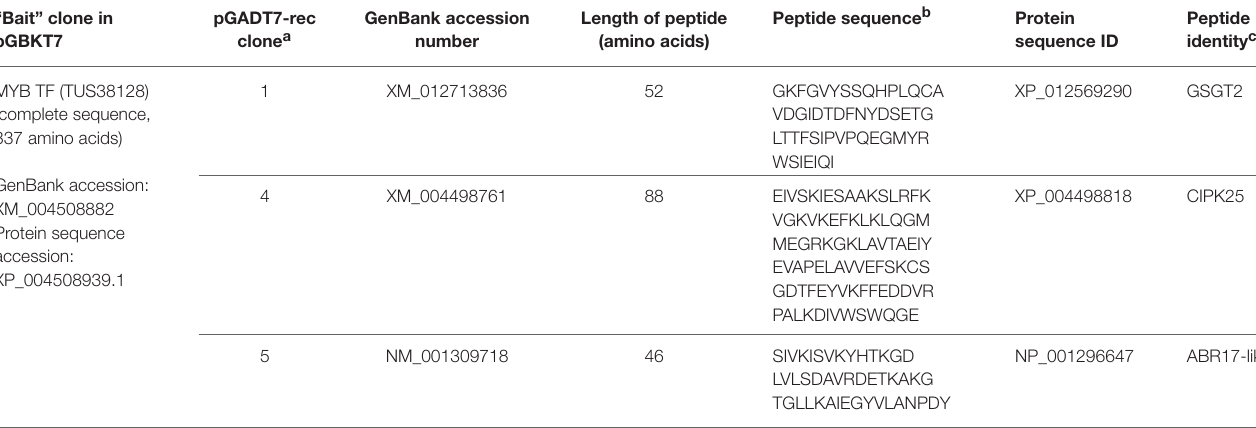
TABLE 2 | Details of the pGADT7-rec clones containing CDS encoding peptides fused to the GAL4 AD, identified through Y2H screening with the bait 1R-MYB protein. “Bait” clone in pGBKT7